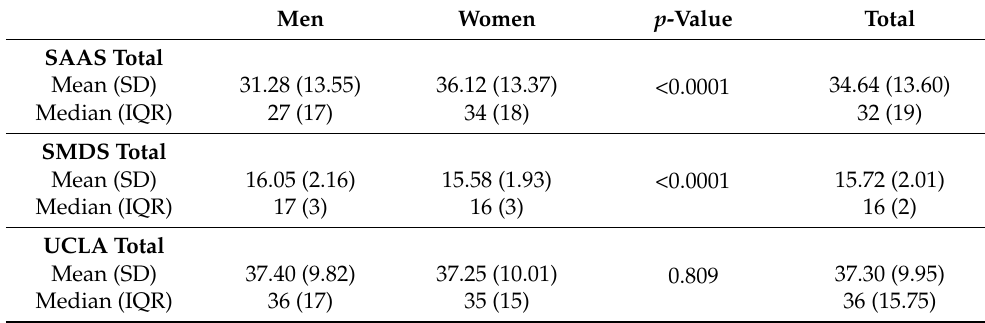
Table 2. Scores of instruments used and differences according to participants’ gender (N = 632).